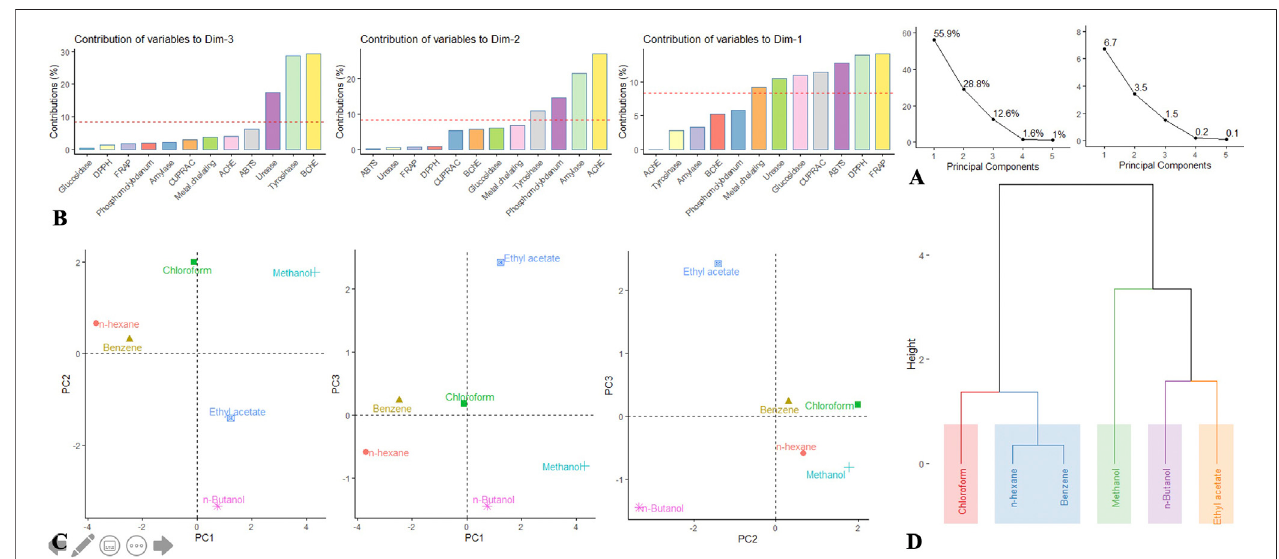
FIGURE 3 | (A – C) Principal component analysis. (A) Eigenvalue and percentage of explained variance by each dimension. (B) Contribution of bioactivities to principal components. (C) Distribution of the samples on the factorial plane PC1 vs PC2, PC1 vs PC3, and PC2 vs PC3. (D) Dendrogram of